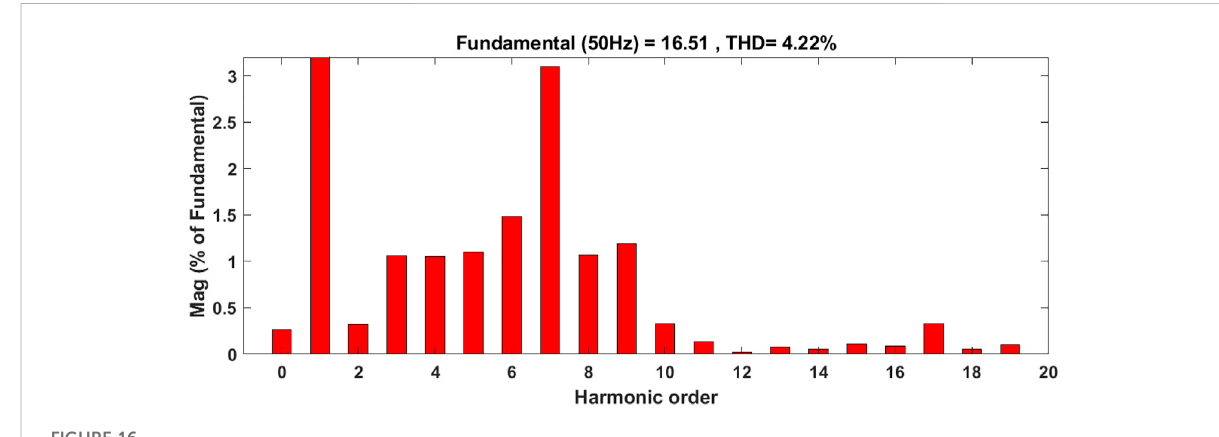
FIGURE 16 % THD of source current for varying load.